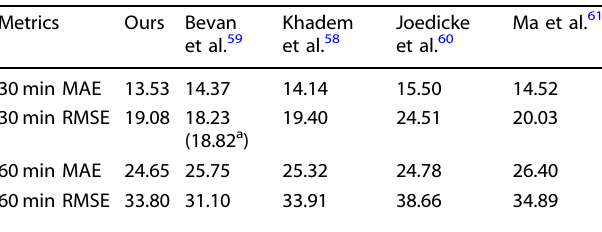
Table 1. Performance comparison between our best model and other models using only blood glucose levels as the model input on OhioT1DM dataset. (a): Regression results for prediction horizon at 30 and 60 min.